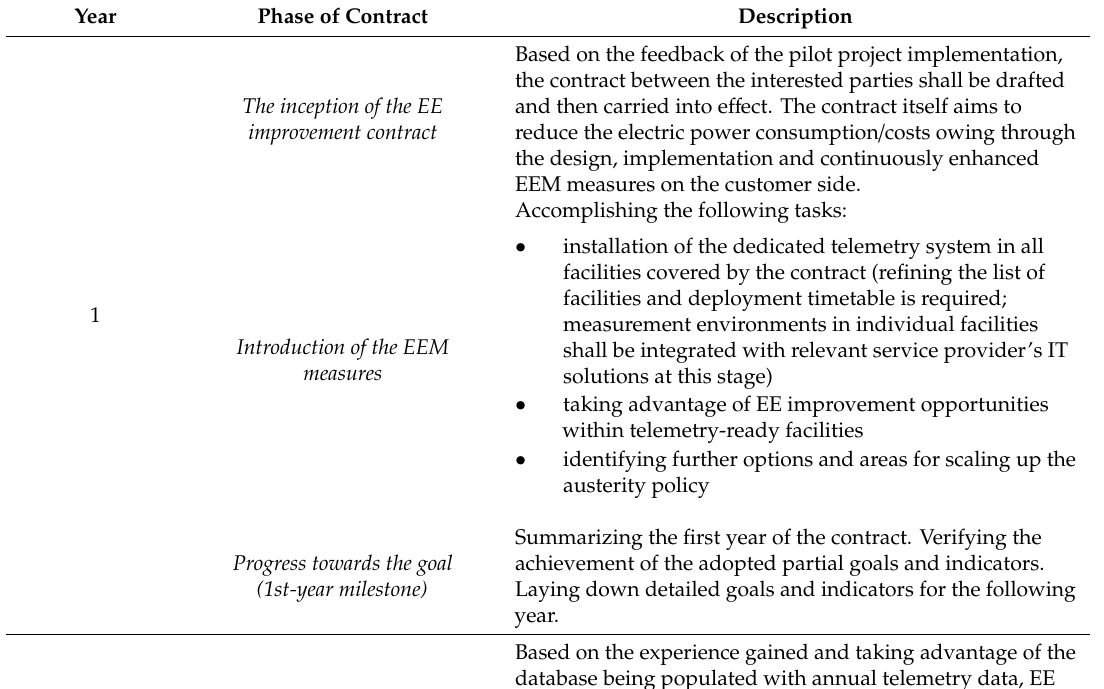
Table 3. Key activities within the EEM